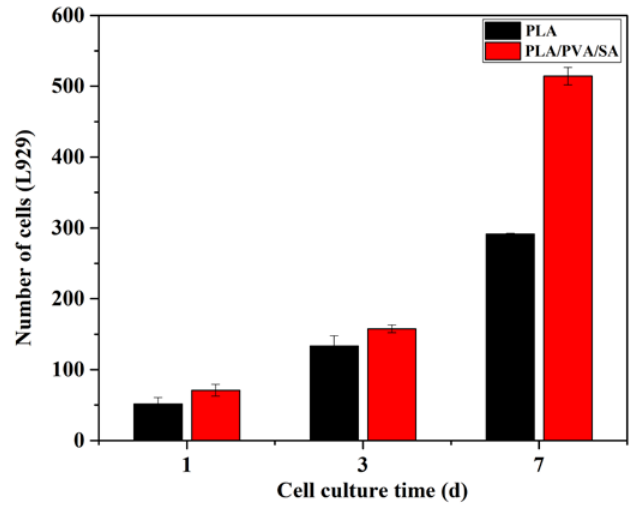
Figure 6. L929 cell counts on PLA and PLA/PVA/SA membranes at the indicated cultured periods.